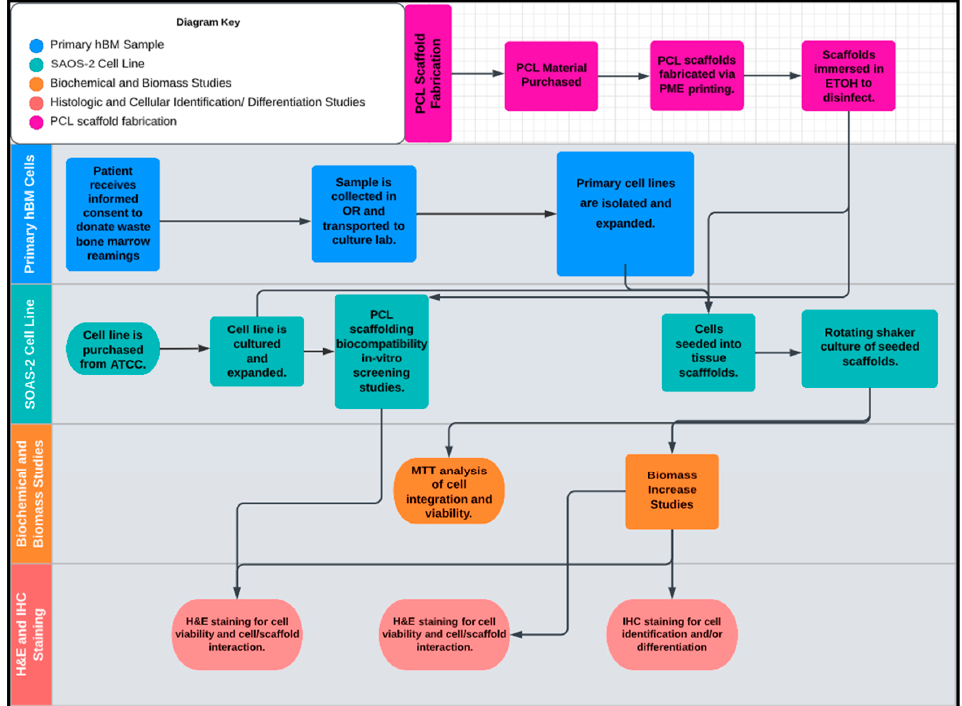
Figure 12. The proposed workflow of this study included five inter-related phases: (1) PCL scaffold microfabrication, (2) primary hBM sample, (3) SAOS-2 cell line, (4) biomechanical and biomass studies, and (5) histologic and cellular identification (differentiation studies).